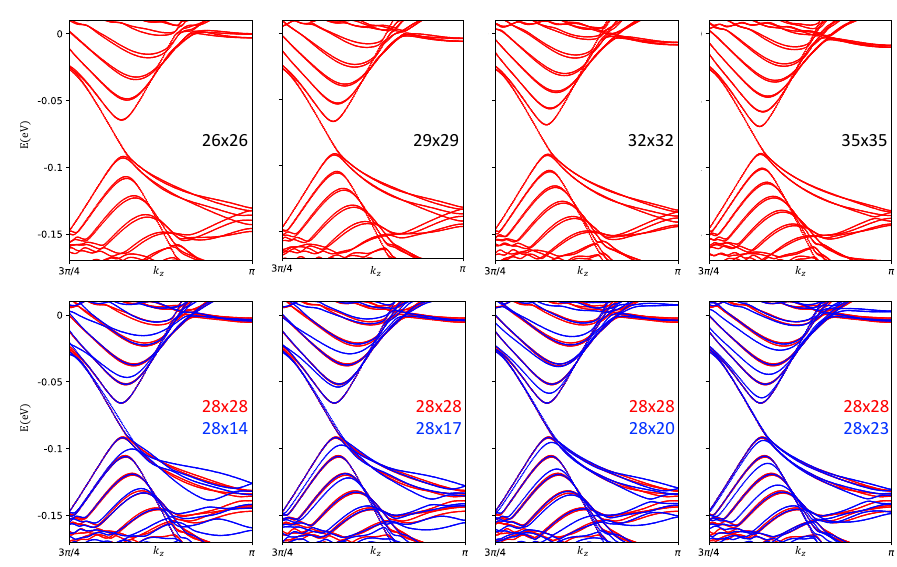
Figure 5: First row: Spectra of square wires with various sizes, the numbers indicate the number of atoms in the outermost layers in both finite directions. The spectra are similar in features, with the bands get denser for increasing sizes. Second row: Spectra of rectangular wires with a fixed width of 28 atoms and increasing height (blue), compared to the spectrum of a square wire with 28 atoms in width and height (red). Some of the bands do not change with size, and are located close to the four nearly degenerate bands of the 28x28 wire bands, these bands originate from the two facets of width 28 atoms. Other bands get denser as the size of the rectangular wire increases, they originate from the facets with increasing width. When two doubly degenerate bands overlap, a small mixing